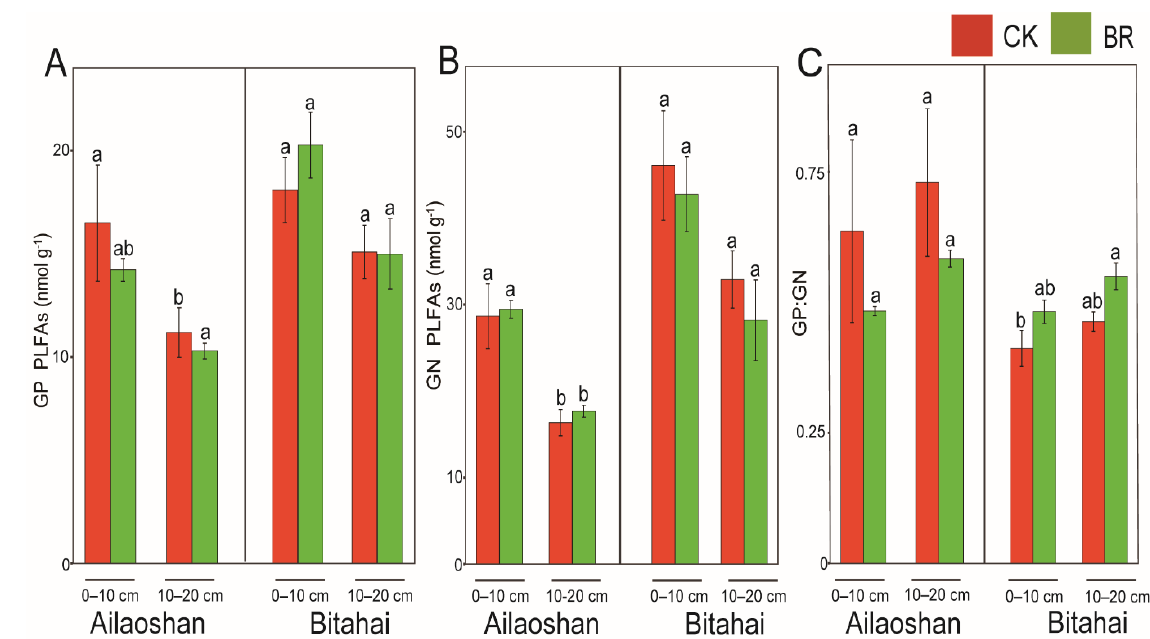
Figure A1. Effects of bryophyte removal (CK: bryophytes not removed, BR: bryophyte removed) and soil depth (0–10 and 10–20 cm) on soil microbial PLFAs in Ailaoshan and Bitahai. ( A ): GP PLFAs: Gram-positive bacterial PLFAs, ( B ): GN PLFAs: Gram-negative bacterial PLFAs, ( C ): GP:GN: ratio of Gram-positive bacterial PLFAs to Gram-negative bacterial PLFAs. Values are the means ± SE of six plots. Different lowercase letters mean significant differences at P < 0.05 between treatments.